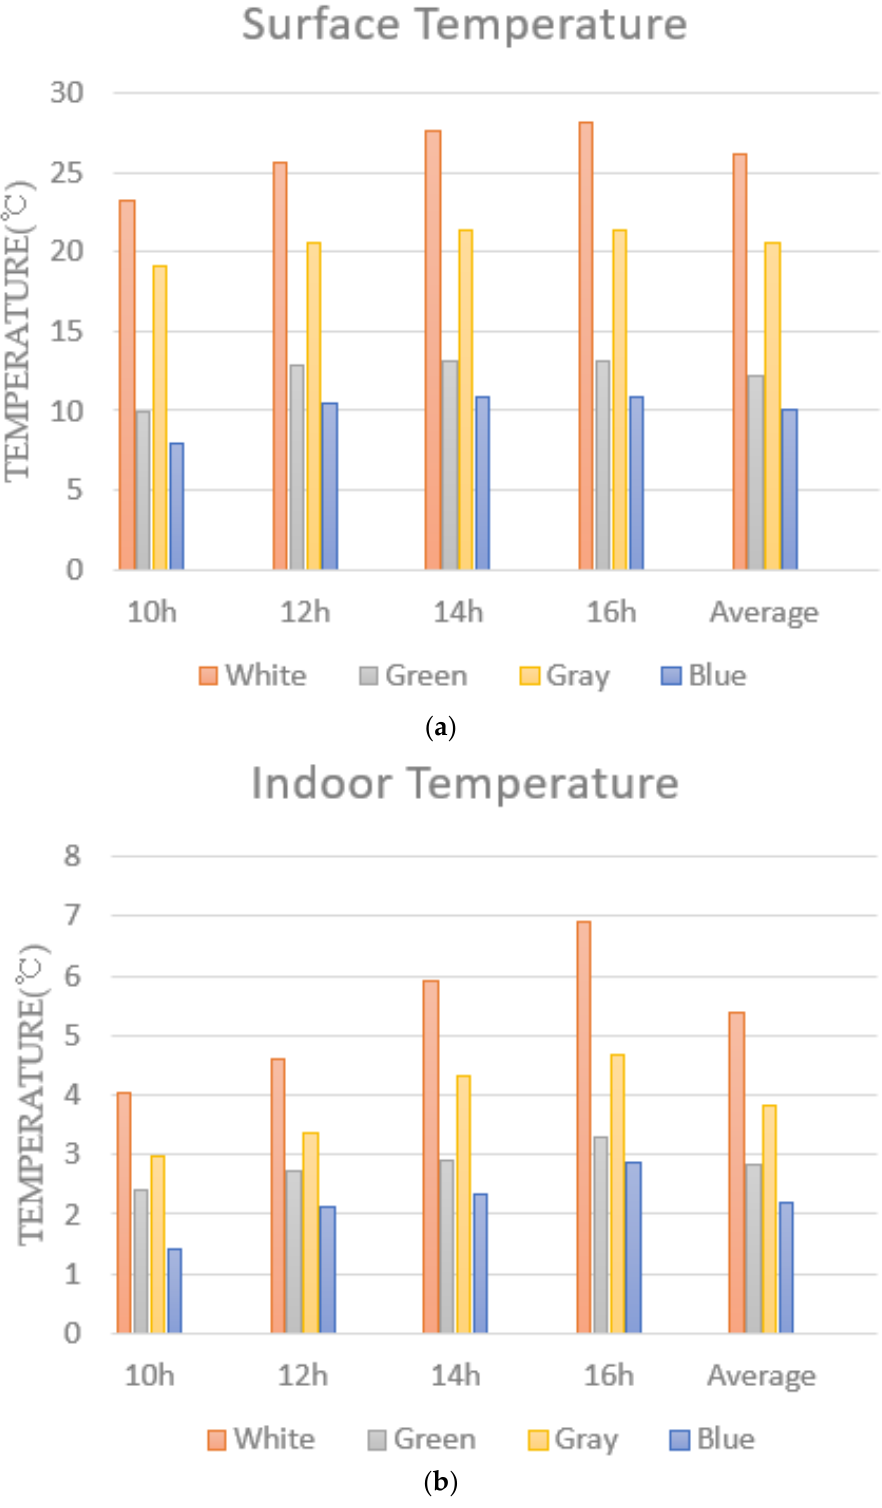
Figure 8. Overall average surface and indoor temperatures by colors ( °C ): ( a ) surface temperature and ( b ) indoor temperature